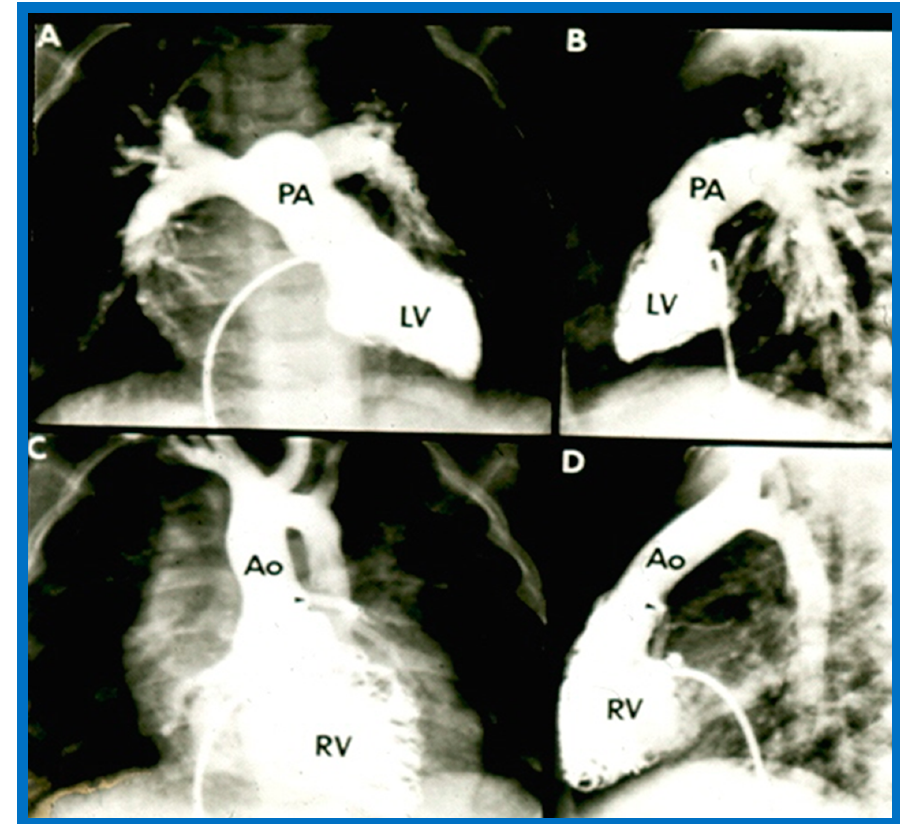
Figure 35. ( A , B ). Selected cine frames of the Left ventricle (LV) in posteroanterior ( A ) and lateral ( B ) projections of a child with d-transposition of the great arteries illustrating morphologic LV with fine trabeculations. The pulmonary artery (PA) originates from the LV. The pulmonary valve is positioned inferior and posterior to its normal position. ( C , D ). Selected cine frames of the right ventricle (RV) in posteroanterior ( C ) and lateral ( D ) projections of the same child shown in ( A , B ) illustrating morphologic RV with coarse trabeculations. The aorta (Ao) originates from the RV. The aortic valve is positioned superior and anterior ( C , D ) to its normal position. The closeness of the mitral with the pulmonary valve in a morphologic LV ( A , B ) and the separation of tricuspid and aortic valves in a morphologic RV (particularly in D ) is clearly seen. Replicated from reference